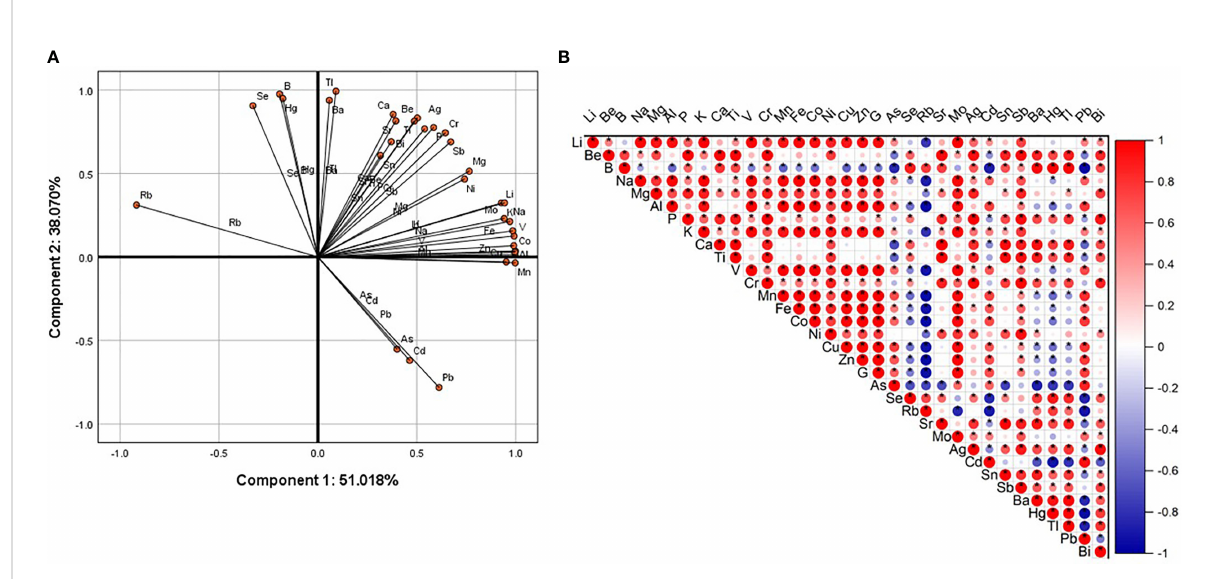
FIGURE 2 Principal component analysis and correlation analysis. (A) Use SPSS (version 25.0) software to carry out the PCA of total element content (logarithm based on 10). The fi rst component (x axis) is 51.018%, and the second component (y axis) is 38.070%. (B) Use Origin software to perform correlation analysis on the rotated score matrix output by PCA. Positive correlation (red), negative correlation (blue). The color depth and the size of the circle are related to the strength of the correlation. The “ * ” sign indicates signi fi cant